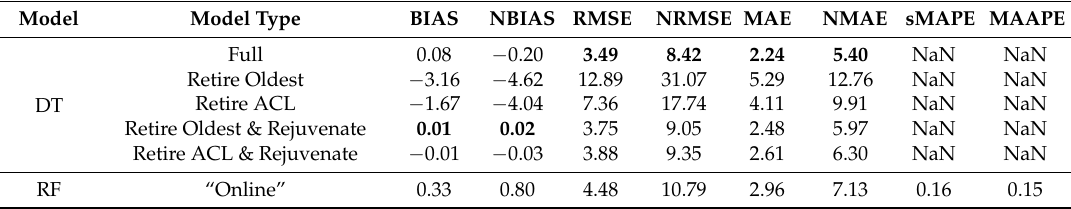
Table 9. One-day ahead forecasting error evaluation for the different selected types of DT with linear model and for the selected “Online” RF, for a rolling window of 50 days. BIAS, RMSE and MAE are in the same units as the electricity price (c € /kWh); NBIAS, NRMSE, NMAE, sMAPE and MAAPE are in